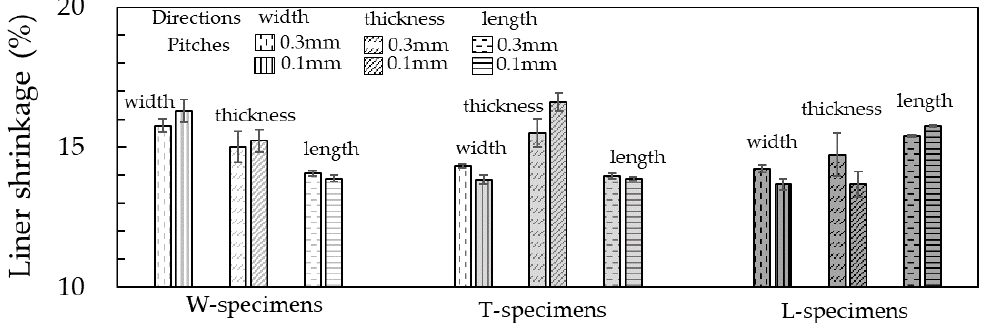
Figure 4. Results of dimensional linear shrinkage from green parts to silver parts printed in various layer directions and layer